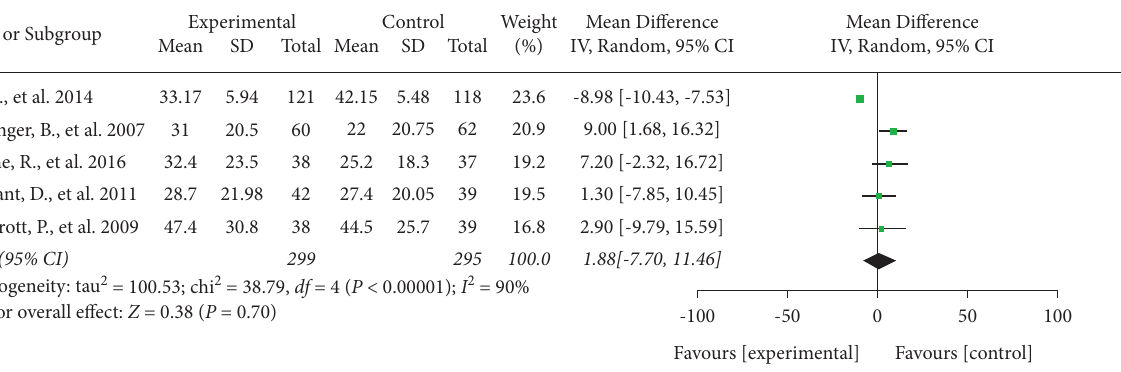
Figure 2: Effects of TCMBE on neck pain intensity. TCMBE: traditional Chinese mind and body